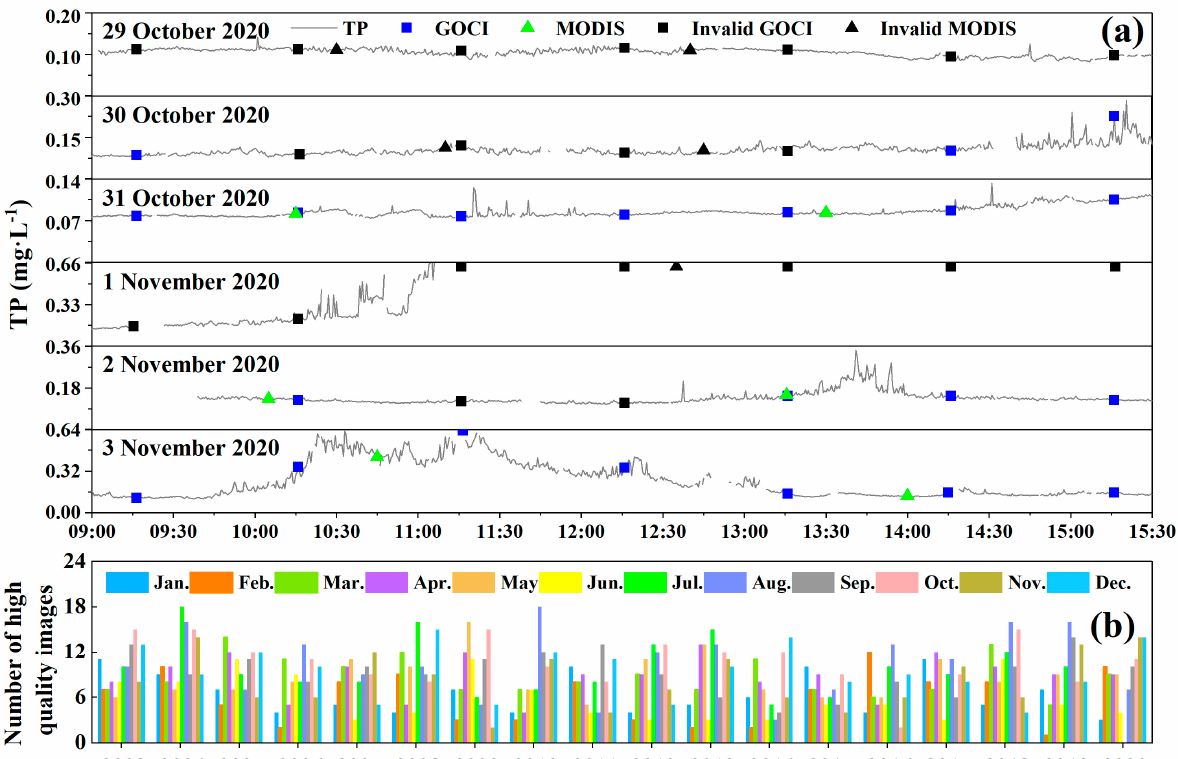
Figure 5. The time and cloud conditions of MODIS and GOCI images covering Lake Taihu from 29 October to 3 November 2020 ( a ) and the distribution of monthly cloud-free high-quality MODIS images covering Lake Taihu from 2003 to 2020 ( b ).